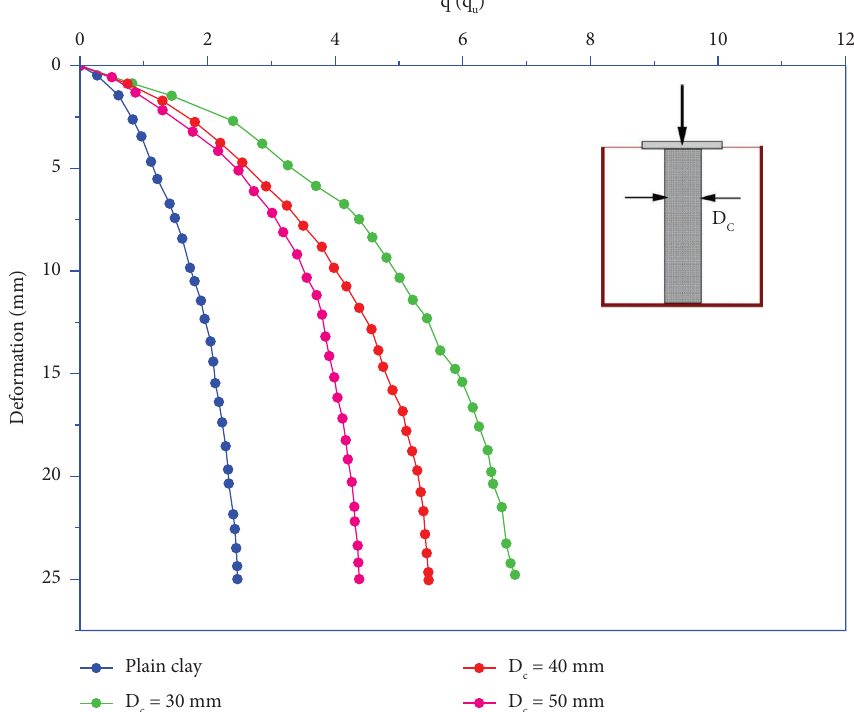
Figure 10: q / q u (ratio of applied vertical stress and unconfned compressive strength) versus settlement ( S ) curve for various diameters of cinder gravel column.